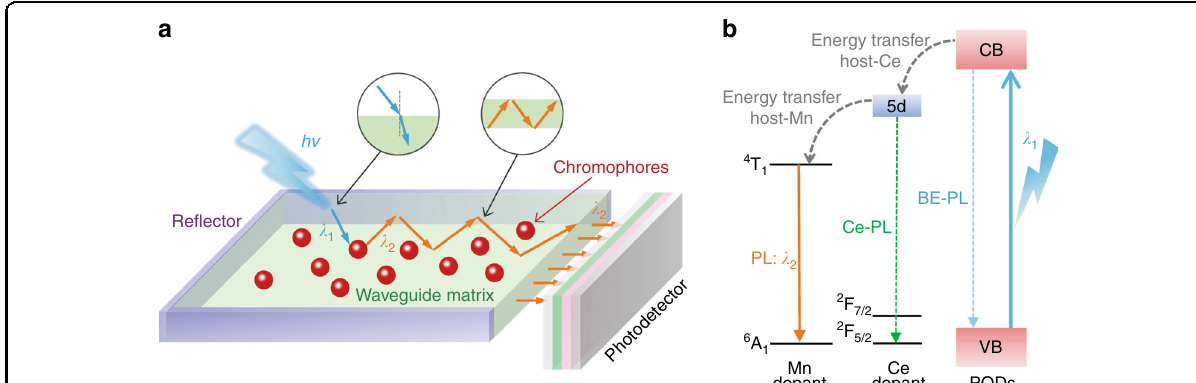
Fig. 1 Working mechanism of the luminescent concentrator for photodetection. a Schematic device architecture of the LC-coupled heterostructure photodetector. The insets above indicate the incident light refraction at PMMA surface and waveguiding of emitted light by total internal re fl ection, respectively. b Energy transfer process of Cr 3 + , Ce 3 + , Mn 2 + doped CsPbCl 3 PQDs. The band edge, Ce 3 + and Mn 2 + PL followed by excitation ( λ 1 ) are shown by the blue dash, green dash and orange solid arrows, respectively. High PLQY Mn-PL ( λ 2 ) is due to the ef fi cient energy transfer from